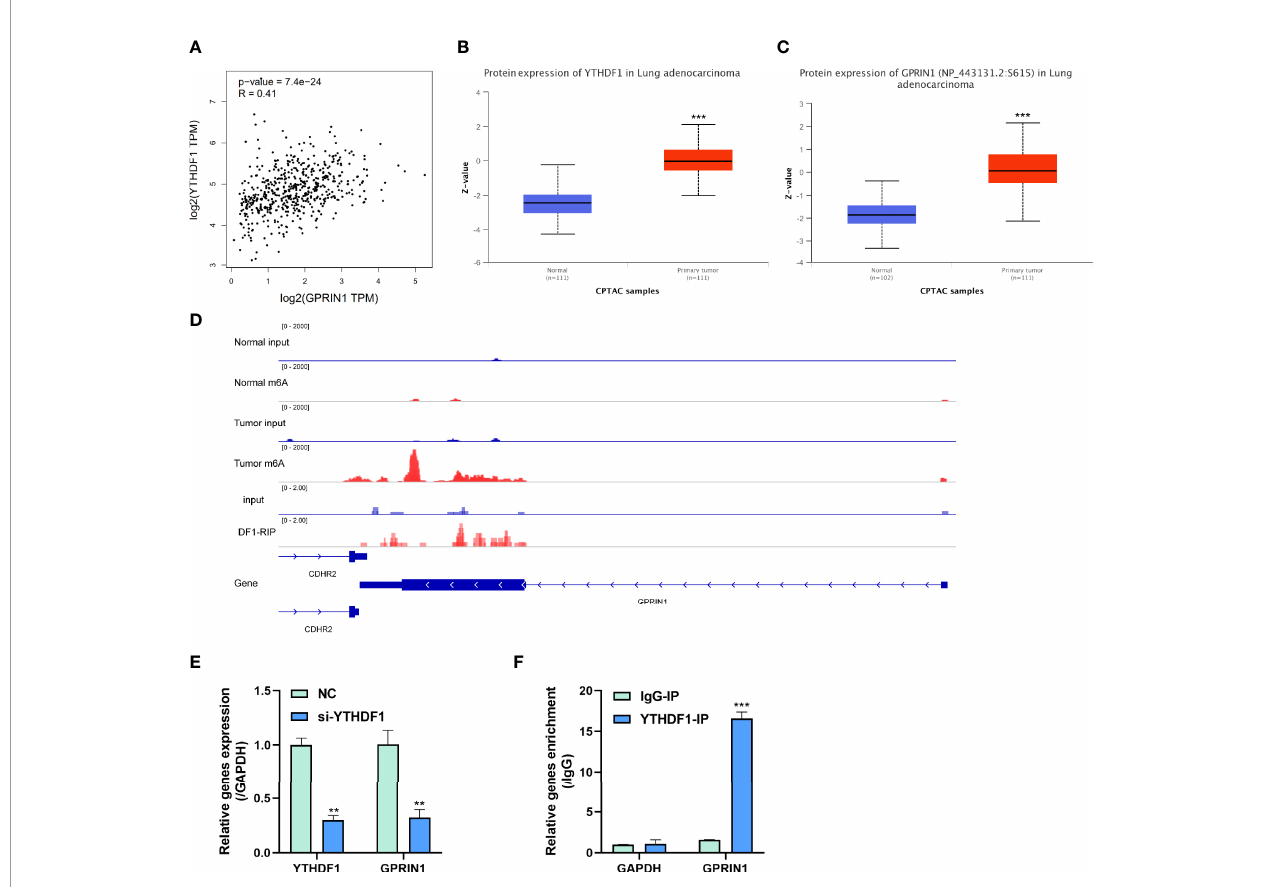
FIGURE 6 | m6A reader YTHDF1 regulated GPRIN1 expression. (A) A strong positive correlation between YTHDF1 and GPRIN1 in the GEPIA2 database. (B, C) The protein expression of YTHDF1 and GPRIN1 in the CPTAC database, respectively. (D) Tumor m6A signal was increased at speci fi c positions 3 ’ UTR of GPRIN1. The region with a gain of m6A in LUAD is the same that gains enrichment of YTHDF1 in A549 cells. (E) Knockdown of YTHDF1 downregulated the RNA levels of GPRIN1 in LUAD A549 cells. (F) RIP-derived RNA in A549 cells was measured by RT-qPCR. P *<0.5, P **<0.01, P